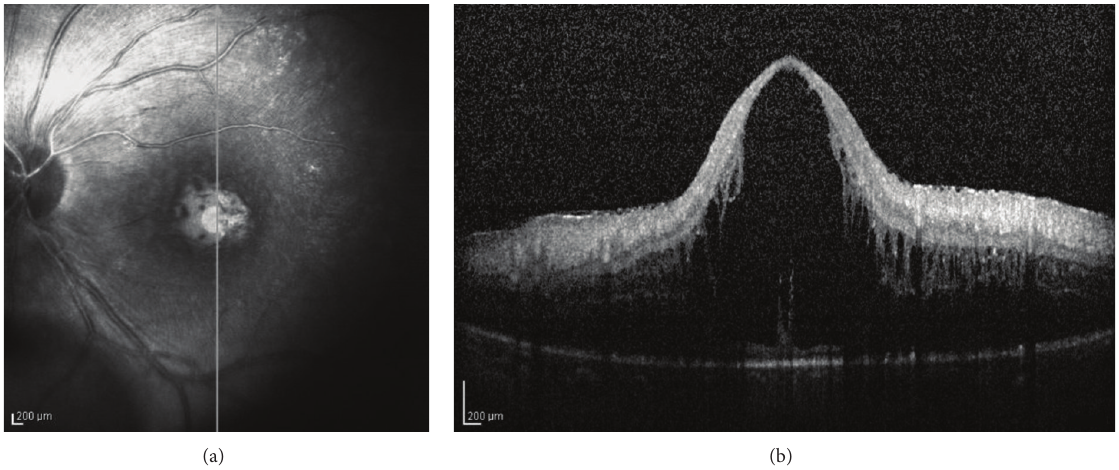
Figure 1: Patient no. 2: left eye. Scanning laser ophthalmoscope fundus image (on the left) showing the position of optical coherence tomography (OCT) section. Spectralis OCT (on the right) shows severe macular edema (foveal thickness 1160 𝜇 m).